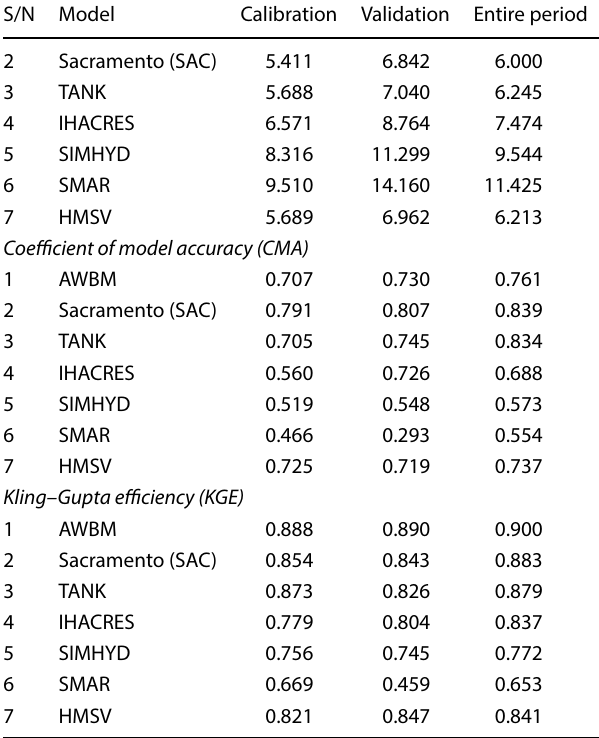
Table 3 Statistical performance evaluation of the